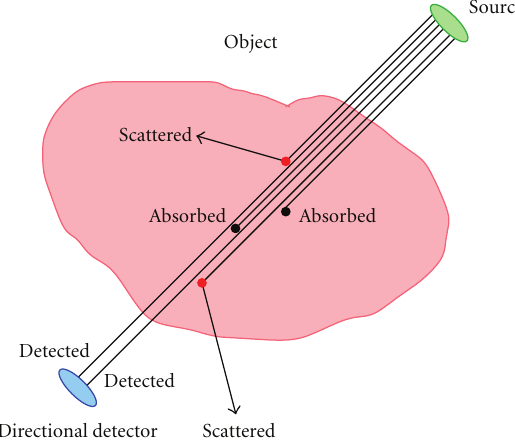
Figure 2: Illustration of the problem of photon attenuation resulting from photoelectric absorption and Compton scattering.